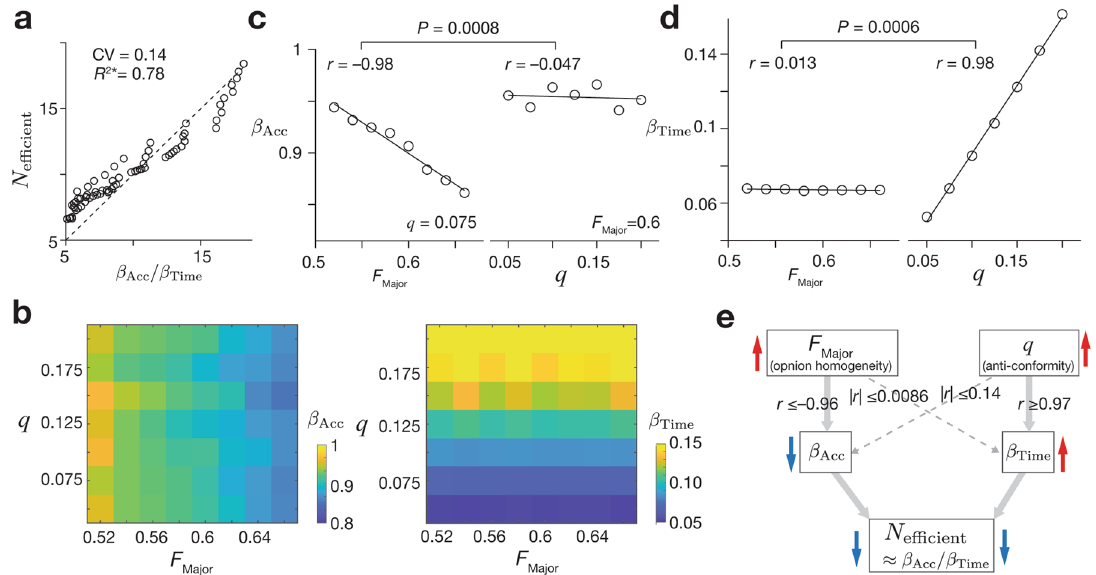
Fig. 3 Determinants of ef fi cient jury size. a The most ef fi cient jury size N ef fi cient could be approximated by β Acc / β Time , where β Acc and β Time are regression coef fi cients in ln Δ 〈 Accuracy 〉 = β Acc ln N + ε Acc and ln 〈 T 〉 = β Time N + ε Time . CV represents the coef fi cient of variation and R 2* denotes the adjusted coef fi cient of determination in a regression model using N ef fi cient = β Acc / β Time . b – e We calculated β Acc and β Time in broader ranges of F Major and q ( b ) and estimated correlation coef fi cients between them. The panels c and d show the exemplary results of the correlation analyses. β Acc was speci fi cally correlated with F Major ( c ), whereas β Time was exclusively correlated with q ( d ). These observations indicate that larger F Major decreases N ef fi cient by reducing β q decreases N β r shows a correlation coef fi cient and P indicates the statistical Acc , whereas larger ef fi cient by increasing Time ( e ). In the panels c and d , signi fi cance in a test of the signi fi cance of the difference of the correlation coef fi cient.